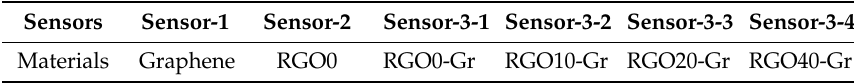
Table 1. Relationship of sensor name and sensing material.